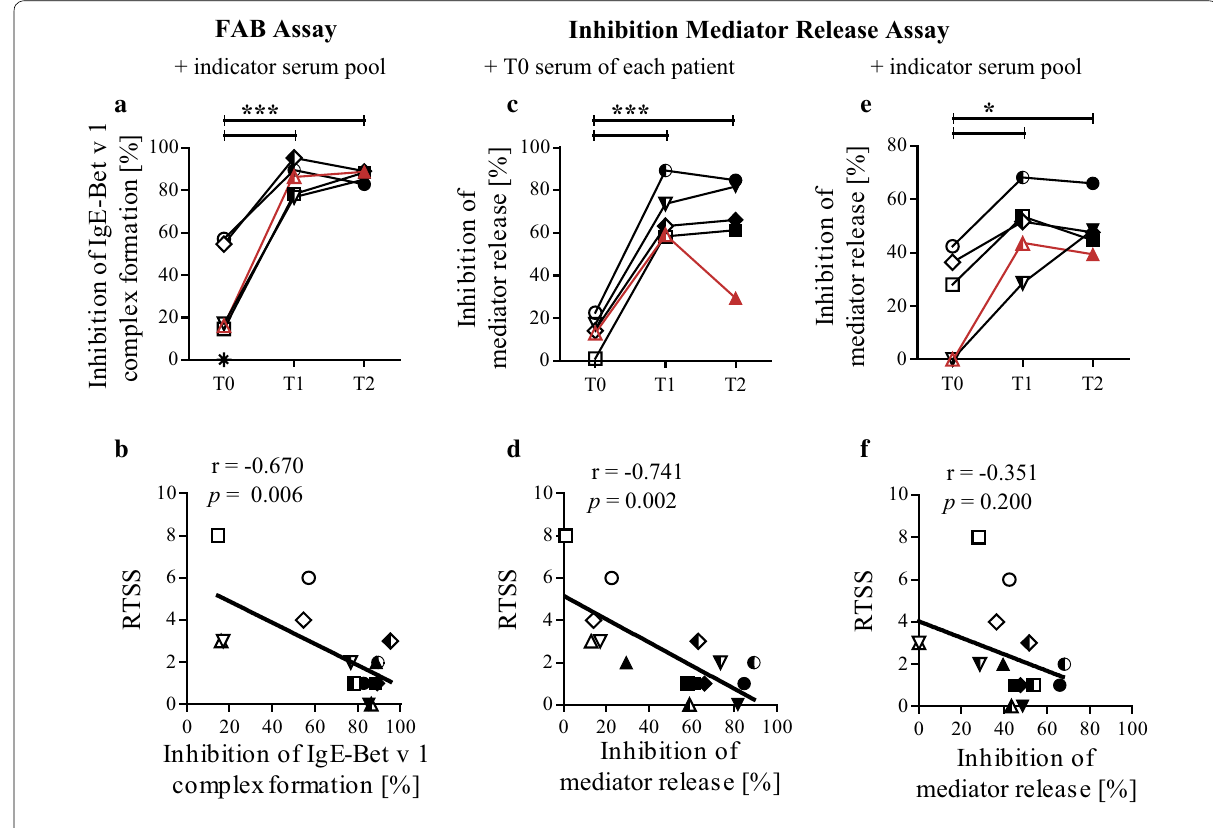
Fig. 7 Inhibition of IgE-Bet v 1 binding during AIT and in control sera. Inhibition assays and correlation of complex destruction with RTSS are given for FAB ( a , b ), inhibition mediator release assays with T0 serum of each patient ( c , d ) and indicator serum pool ( e , f ) used as reference for therapy-induced antibodies to inhibit IgE-allergen binding. Statistics were performed with Friedman test and Dunn’s post test. * p < 0.05, *** p < 0.001. Serum of AIT patients (P1–P5) were obtained at three different time points (T0, open; T1, semi-filled; T2, filled